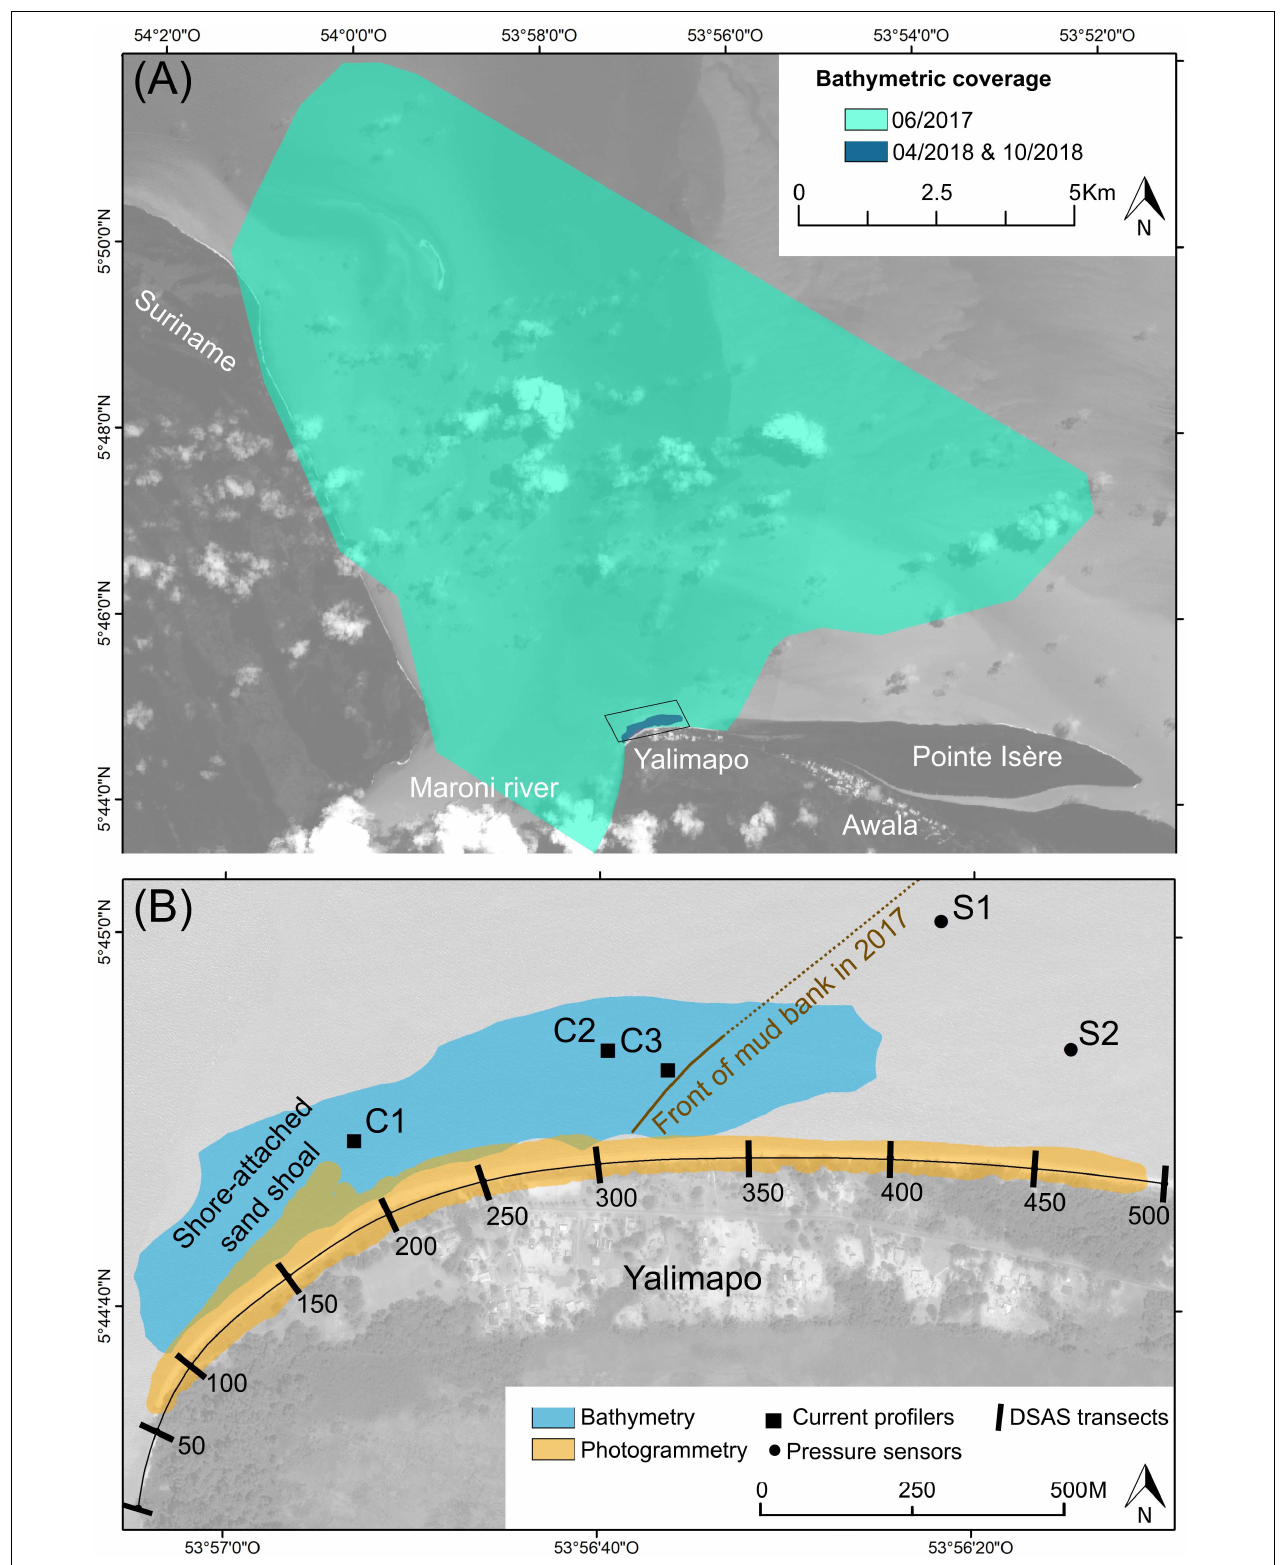
FIGURE 3 | Map of the Maroni estuary showing area of bathymetric coverages in 2017 and location of study area (rectangle) (A) ; instrument deployment points, transects of multi-decadal (1955–2017) shoreline analysis, and areas of photogrammetric and bathymetric coverages in 2018 (B) .